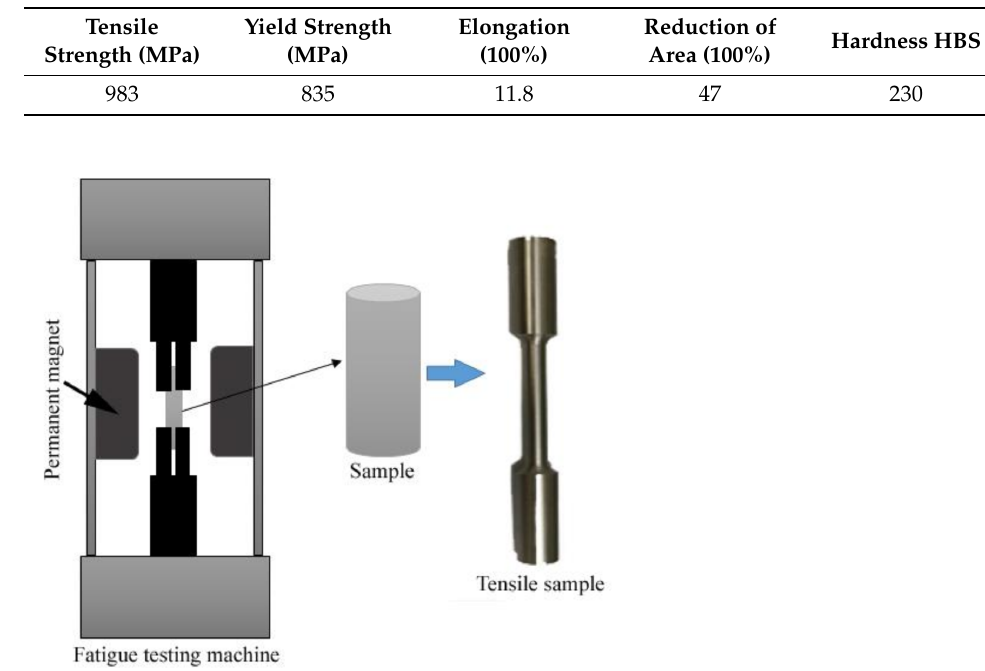
Table 2. The mechanical properties of 35CrMo steel.